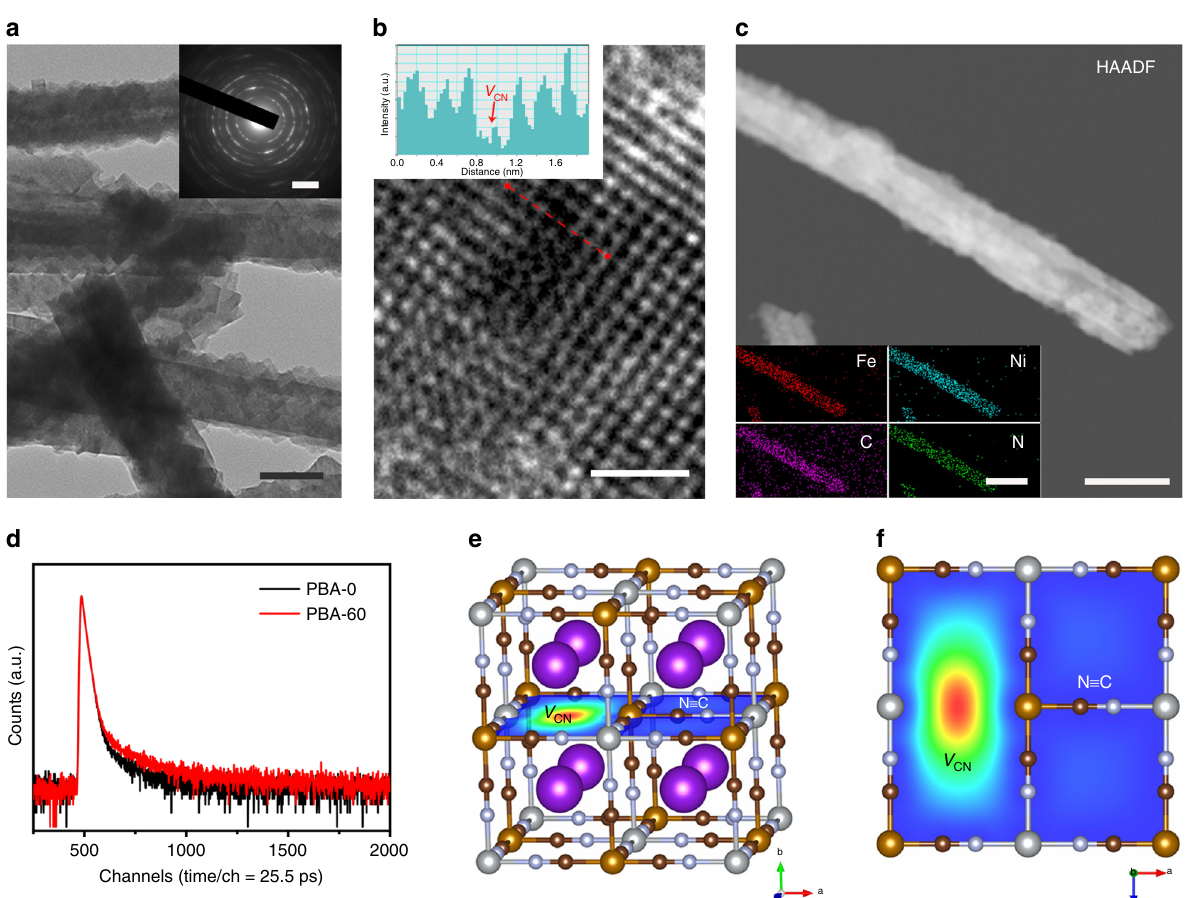
Fig. 2 Characterization of V CN -mediated Ni – Fe PBA. a TEM image of PBA-60. Scale bar, 100 nm. Inset shows the corresponding selected-area electron diffraction pattern. Scale bar, 2 nm − 1 . b HRTEM image of PBA-60. Scale bar, 1 nm. Inset shows the atomic intensity pro fi le along the dotted red line in b . c HAADF image of a typical PBA-60 nanorod. Scale bar, 50 nm. Inset shows the corresponding STEM elemental mappings. Scale bar, 100 nm. d PAS analysis of PBA-0 and PBA-60. e , f Schematic representation of the trapped positrons by V CN -mediated